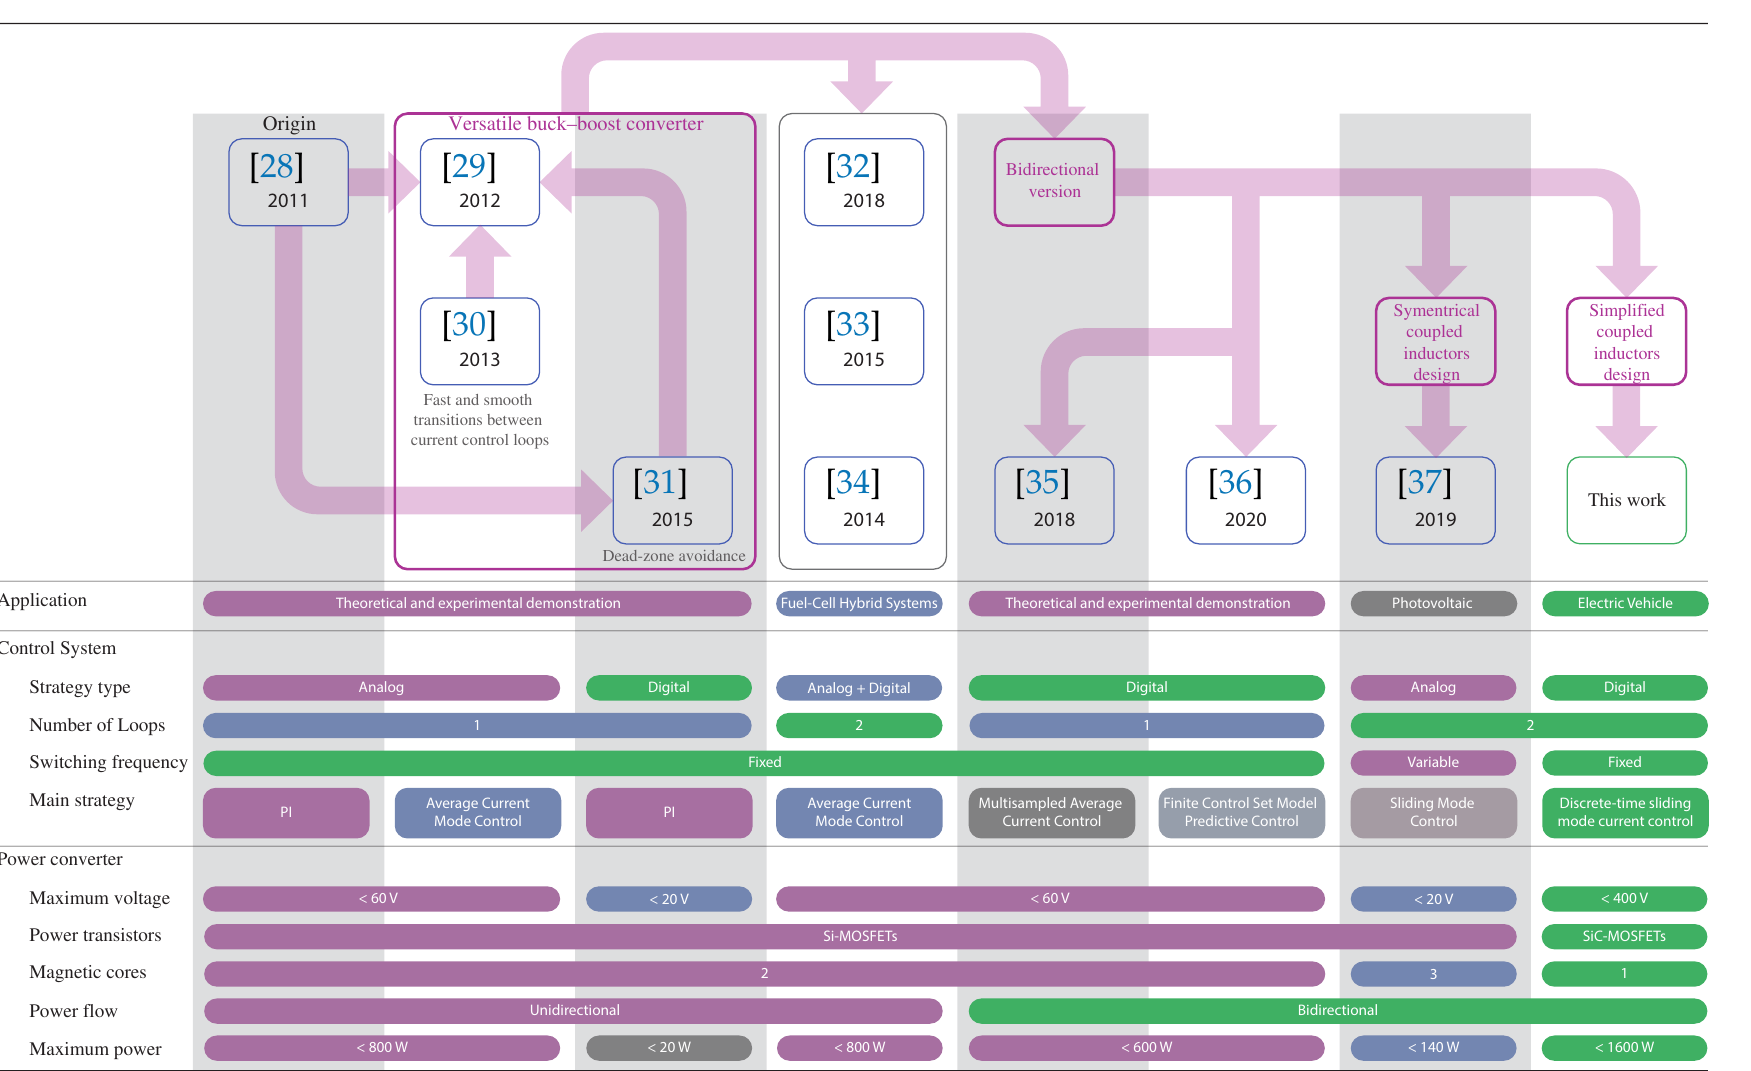
Figure 4. Versatile buck–boost converter evolution throughout all the investigations carried out to